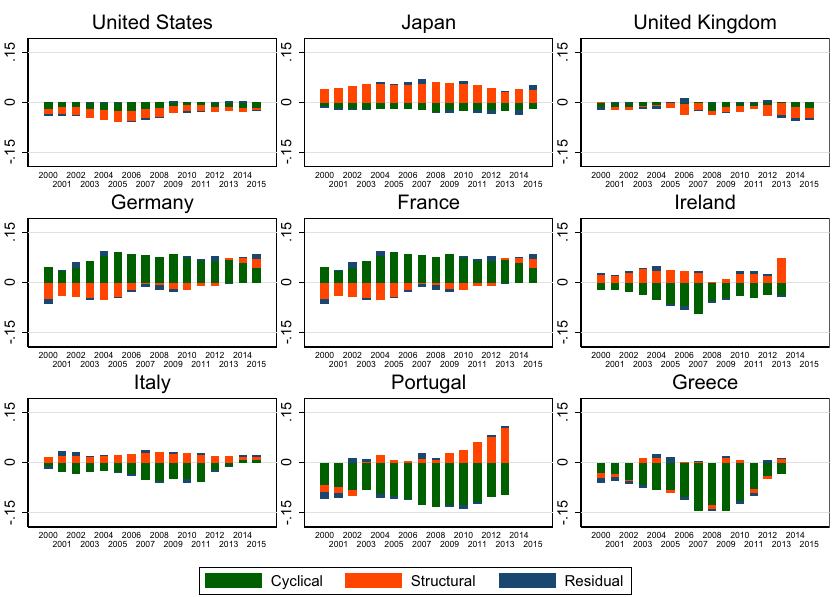
Fig. 12 Current account decomposition for selected countries. Notes. This figure plots the cyclical and structural components of the current account together with the residual term identified from Eq. (2) for a sample of